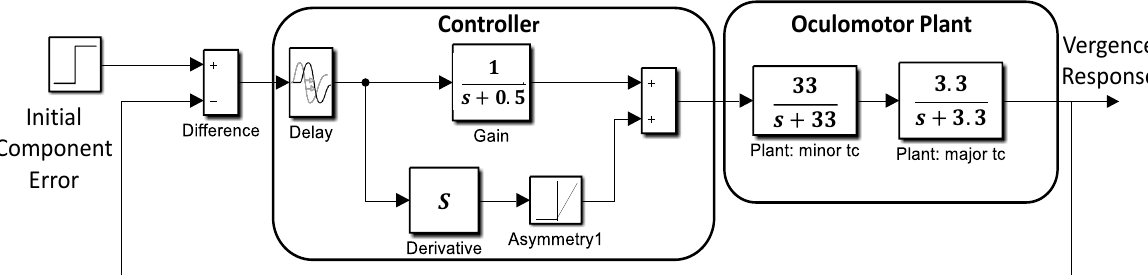
Figure 5: A model of the slow component feedback control system that was used to aid interpretation of the component’s frequency